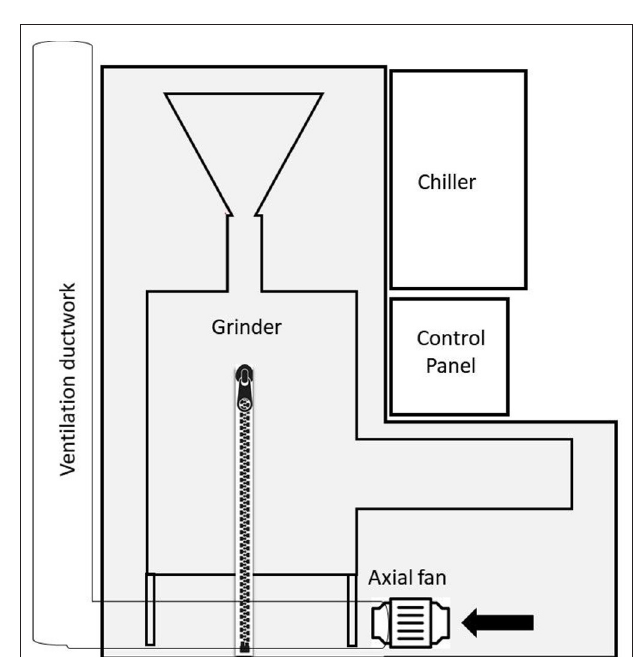
FIGURE 2 | Schematic of ventilated enclosure design. The grinder equipment was enclosed depicted by area shaded in light gray. Both the chiller and control panel were located outside the enclosure. Each enclosure had two zippers to allow access. One axial fan per enclosure was placed on the floor under grinder equipment and connected to ventilation ductwork that was exhausted through the roof.